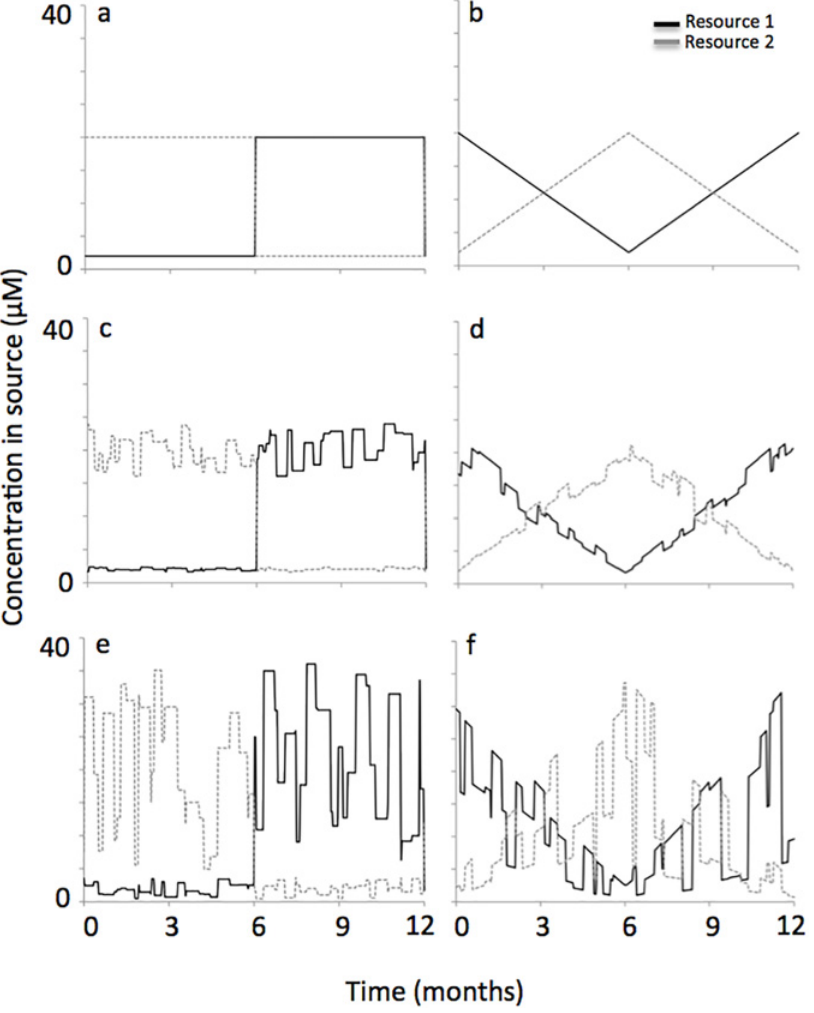
Fig 1. Sudden and gradual modes of reversal in the resource supply concentration. The sudden mode of reversal went from a resource supply of 2 and 20 μ M for resources 1 and 2 to a resource supply of 20 and 2 μ M with an abrupt transition on day 182. Three levels of noise in the resource supply were explore, which were no noise (a), 0 – 20% noise (c) and 0 – 80% noise (e). The gradual mode of reversal also went from a resource supply of 2 and 20 μ M for resources 1 and 2 to a resource supply of 20 and 2 μ M, but with a slow change that reversed direction on day 182. Again, three levels of noise in the resource supply were explore, which were no noise (b), 0 – 20% noise (d) and 0 – 80% noise